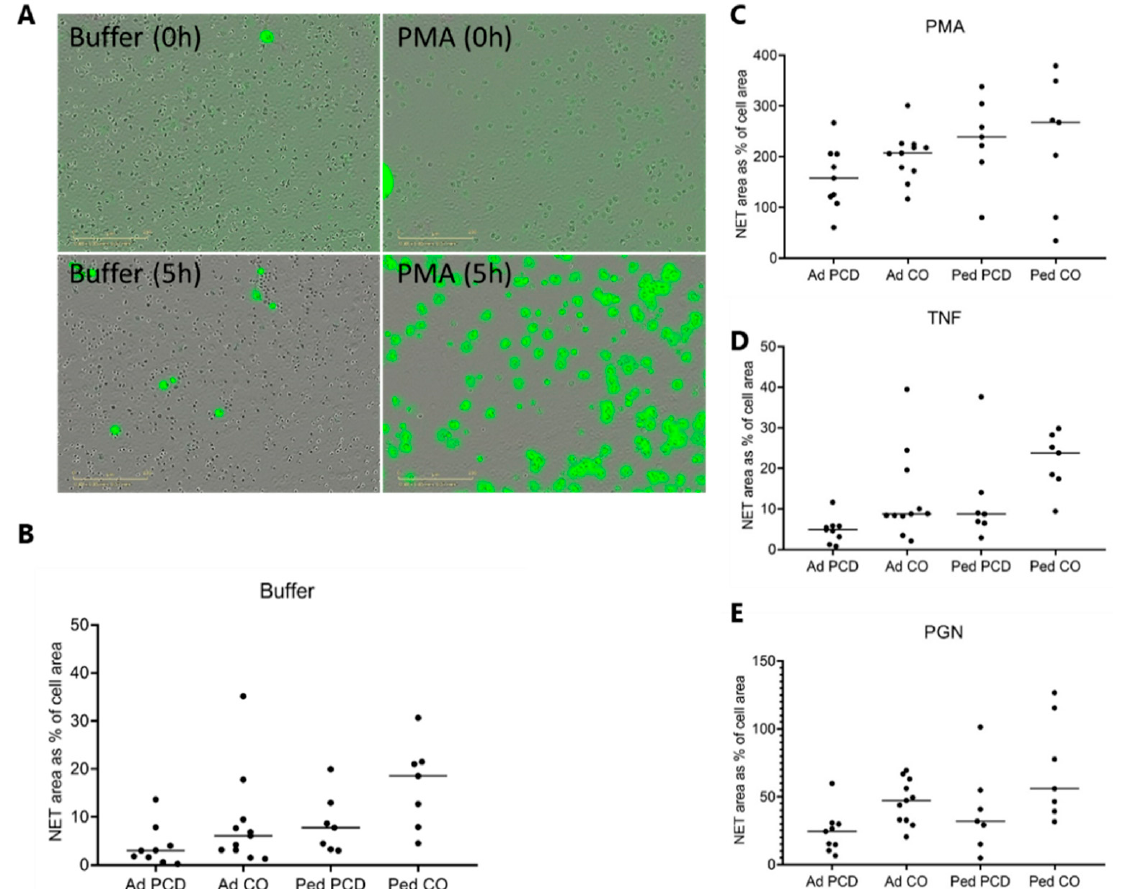
Figure 7. The capacity of PCD PMNs to produce neutrophil extracellular traps is reduced. PMNs from adult patients with PCD (Ad PCD, n = 9), healthy adult controls (Ad CO, n = 11), pediatric patients with PCD (Ped PCD, n = 7) and pediatric controls (Ped CO, n = 7) were stimulated with different compounds and incubated for 5 h in the IncuCyte S3 Live-Cell Analysis System. The fluorescent probe SYTOX Green was used to detect the presence of extracellular DNA. ( A ) A representative set of pictures taken by the IncuCyte shows that the fluorescence increases after 5 h of incubation with buffer or PMA. The cells were stimulated with ( B ) buffer, ( C ) PMA (150 ng/mL), ( D ) TNF (50 ng/mL) or ( E ) PGN (10 µg/mL). The production of NETs upon stimulation is displayed as total area of fluorescence relative to the total cell area at 0 h (in %). Statistical differences were determined by the Kruskal-Wallis test. Subsequent Dunn’s multiple comparison test did not indicate significant differences between patients with PCD and healthy controls.